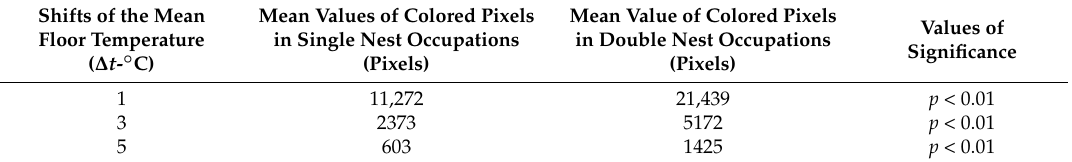
Table 1. Significance of mean values of Colored Pixels (CPs) between real cases of single and multiple nest occupation for each mean floor temperature shift investigated (i.e., 1, 3, and 5 ◦ C). Significance of mean values has been evaluated performing and ANOVA statistical procedure on data collected.